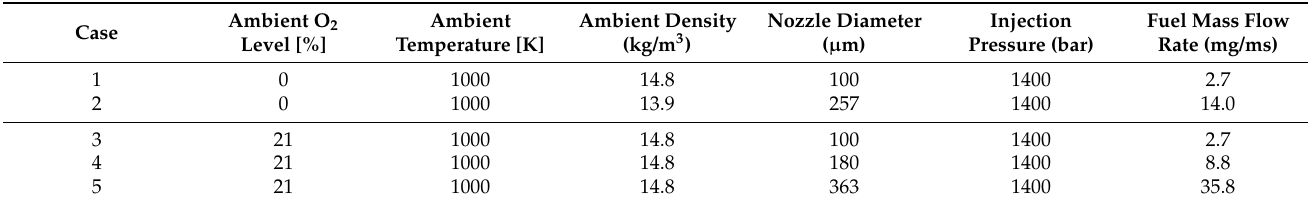
Table 7. Operating conditions and injection specifications in the test cases